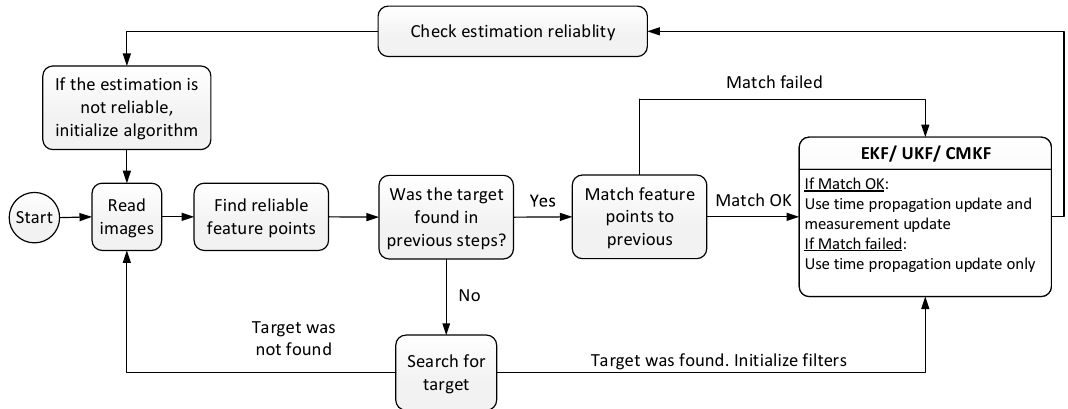
Figure 3. The estimation logic. This scheme consists of a filter re-initialization step, which is activated in case the estimation is no longer